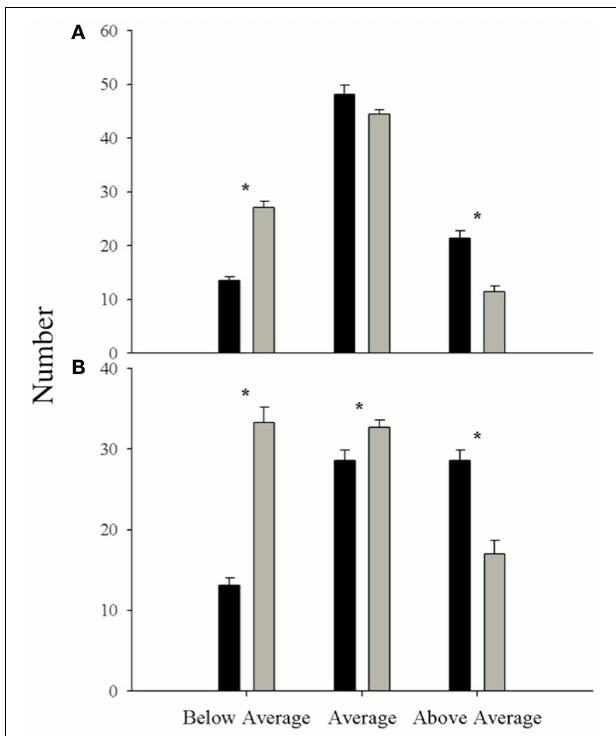
FIGURE 5 | Number of ranchers who observed below normal, normal, or above normal states of (A) herd size and (B) profits for a decade of average (black bars) and below average (gray bars) conditions ( * p < 0 . 05